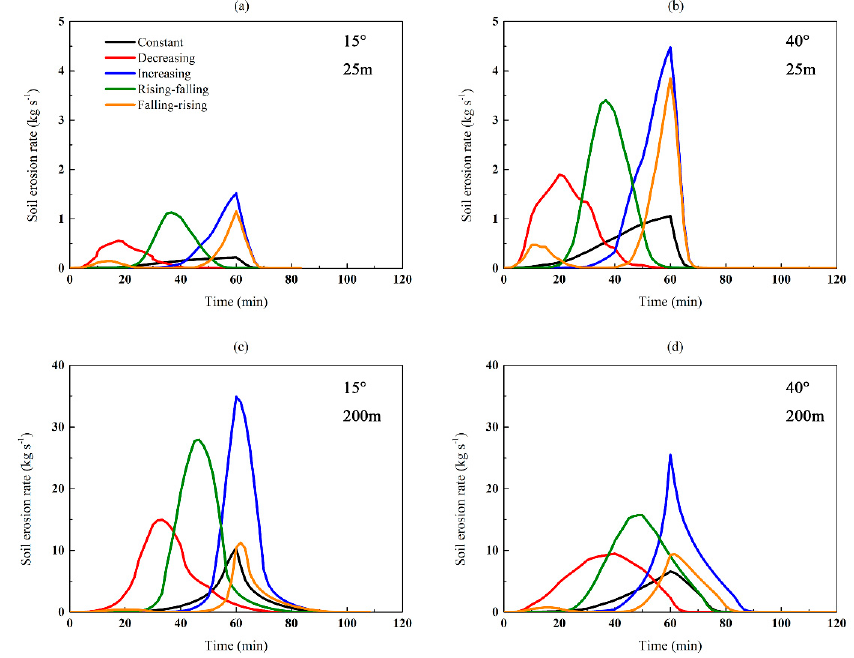
Figure 6. The sedigraphs of five different rainfall patterns with 25 m and 200 projective slope lengths at 15° slope ( a , c ) and 40° slope ( b , d ), respectively.